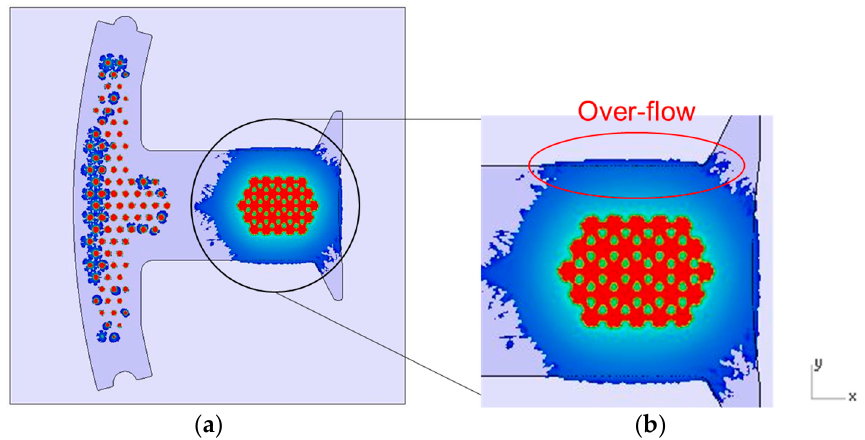
Figure 14. The dipping process results without the fine mesh nets. ( a ) Top view of the dipping process results without the fine mesh nets and ( b ) illustration of partial enlargement of the dipping process results without the fine mesh nets.